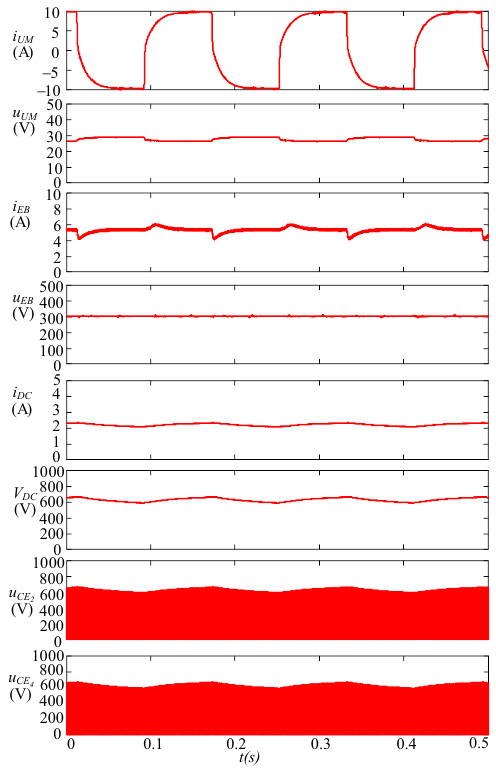
Figure 9. Experimental waveforms of the SPC scheme, for i UM steps from 10 A to − 10